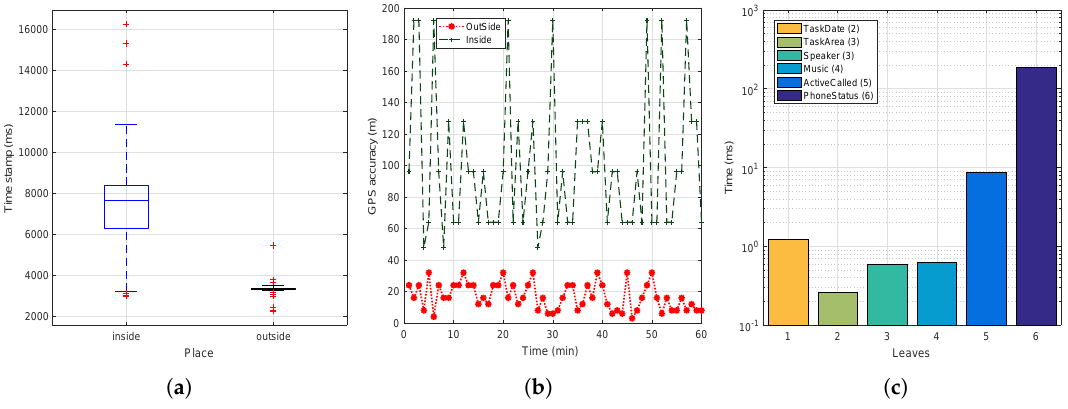
Figure 6. Block size analysis. ( a ) GPS accuracy analysis: indoor vs. outdoor measurements; ( b ) GPS error range; ( c ) Processing time for the different tree elements.